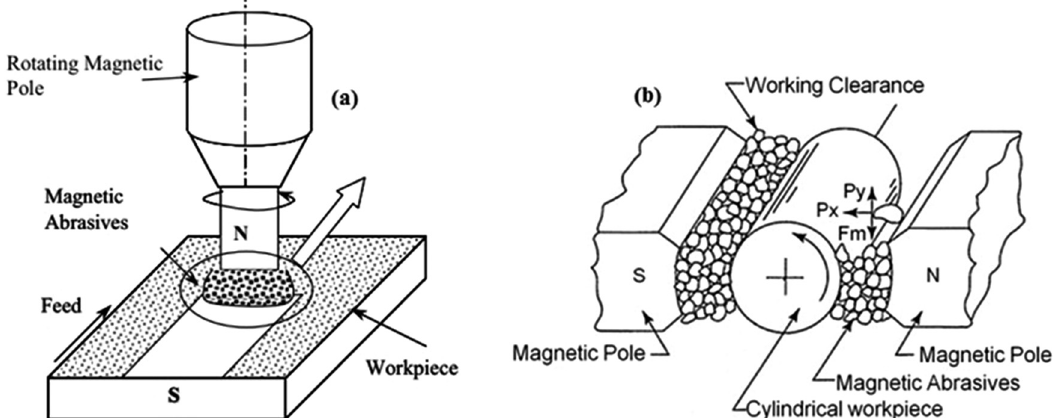
Fig. 1. (a) Plane magnetic abrasive fi nishing, (b) External magnetic abrasive fi nishing of cylindrical